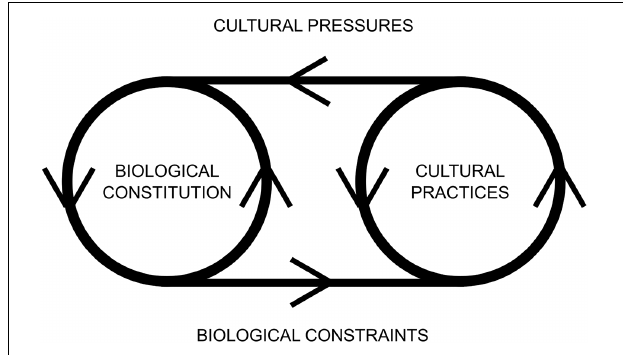
FIGURE 1 | Relations between our biological constitution and our cultural practices. Cultural practices exert some pressure on our biological constitution while our biological constitution constrains the range of possible cultural practices. The two shape each other from an evolutionary approach.